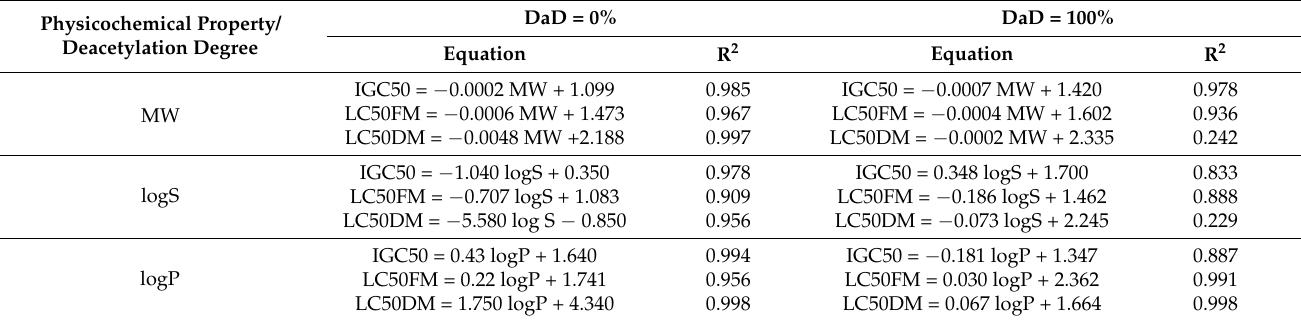
Table 3. Dependence of the predicted values for the aqueous toxicity of investigated chitooligosac- charides on their physicochemical properties: MW—molecular weight, logS—aqueous solubility, logP—partition coefficient, DaD—deacetylation